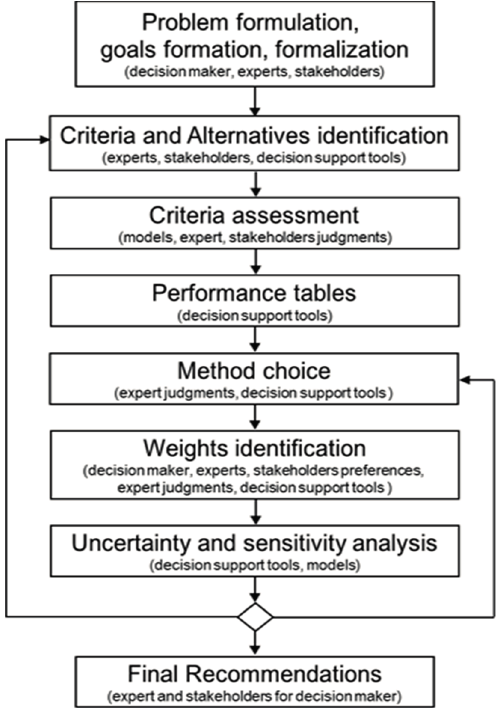
Figure 5. Flowchart of MCDA methods